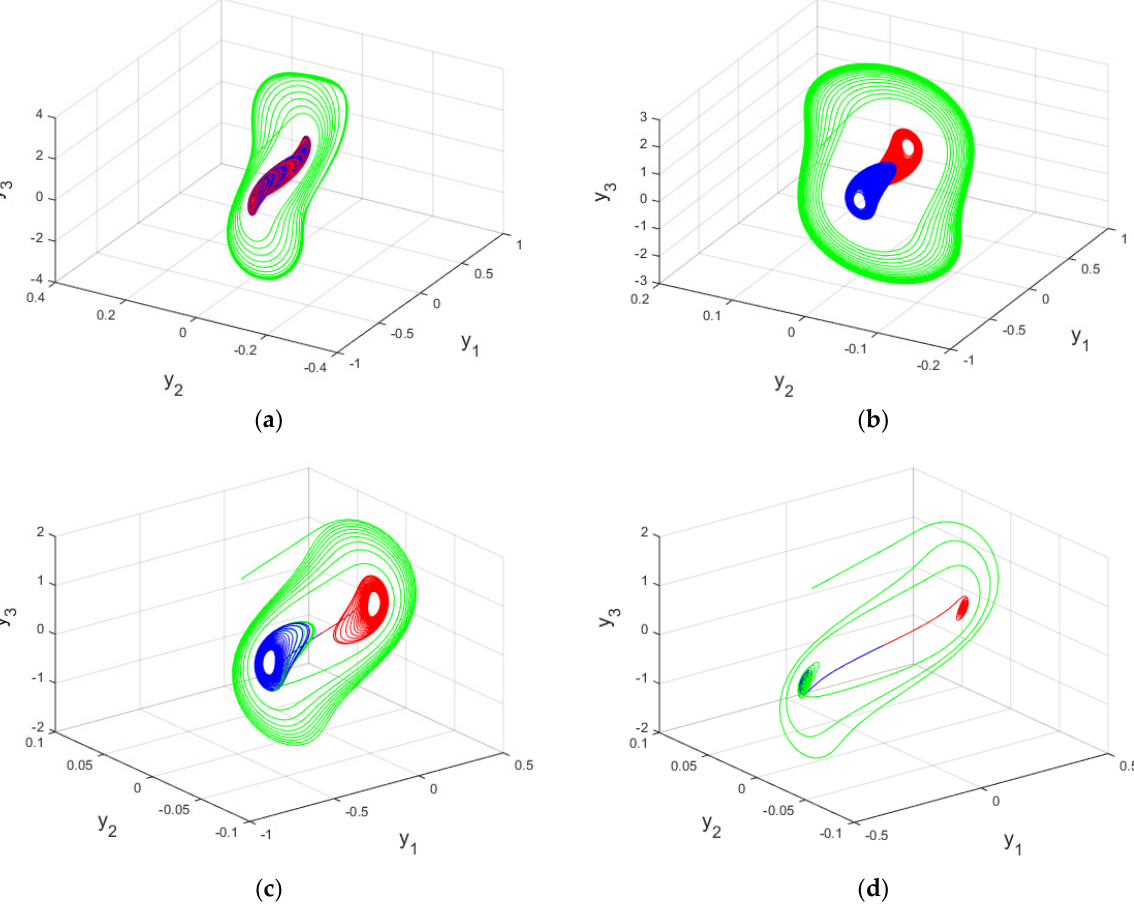
==== ξρδγ Figure 7. Phase graphs of system (4) using 6.1,200,100,1.0 Figure 7. Phase graphs of system (4) using γ = 0.1, δ = 100, ρ = 200 , ξ = 1.6 and: ( a ) q = 0.98, = q = q = q , ( c ) 96.0 and ( d ) 94.0 . ( b ) 97.0 ( b ) q = 0.97, ( c ) q = 0.96 and ( d ) q =